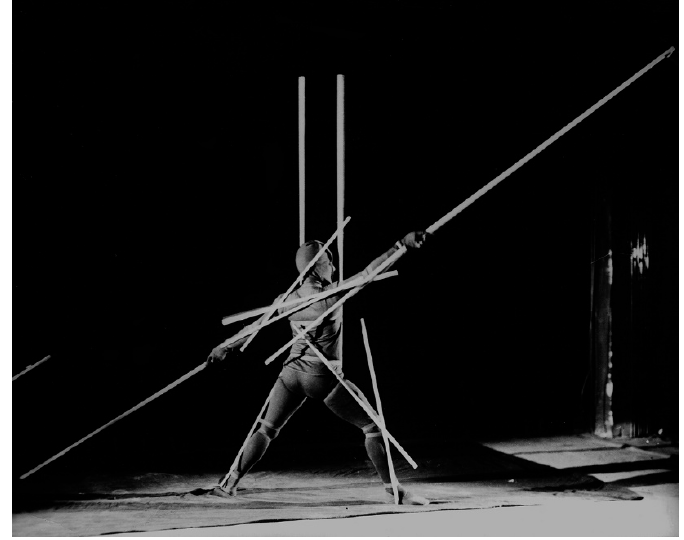
Figure 10. Danse des batons by Oskar Schlemmer, 1928. © 2016 Oskar Schlemmer, Photo Archive C. Raman Schlemmer and used by permission.